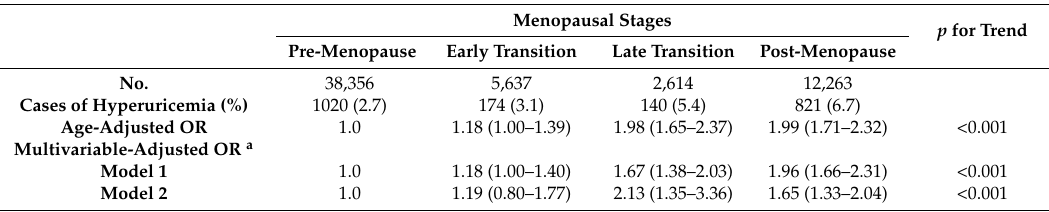
Table 2. Odds ratios (95% confidence intervals) of hyperuricemia (defined as uric acid >6 mg/dL) by menopausal stage.